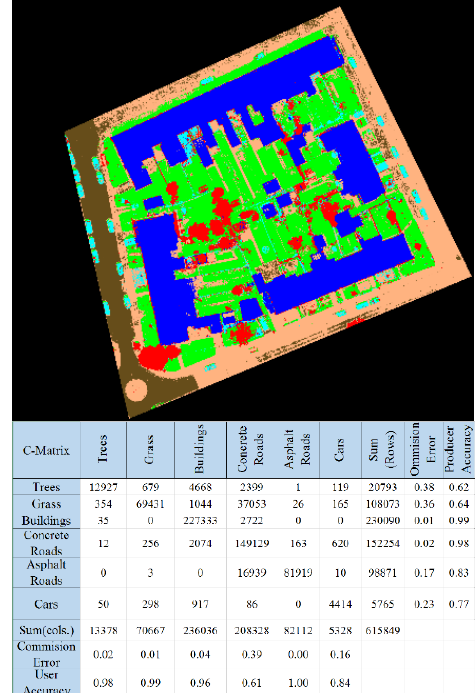
Figure 8. Obtained results from Bayesian classifiers based on LiDAR and image feature space.